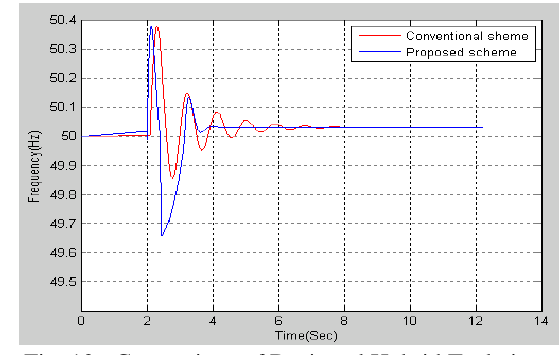
Fig. 12: Comparison of Designed Hybrid Technique with Conventional Technique applied for